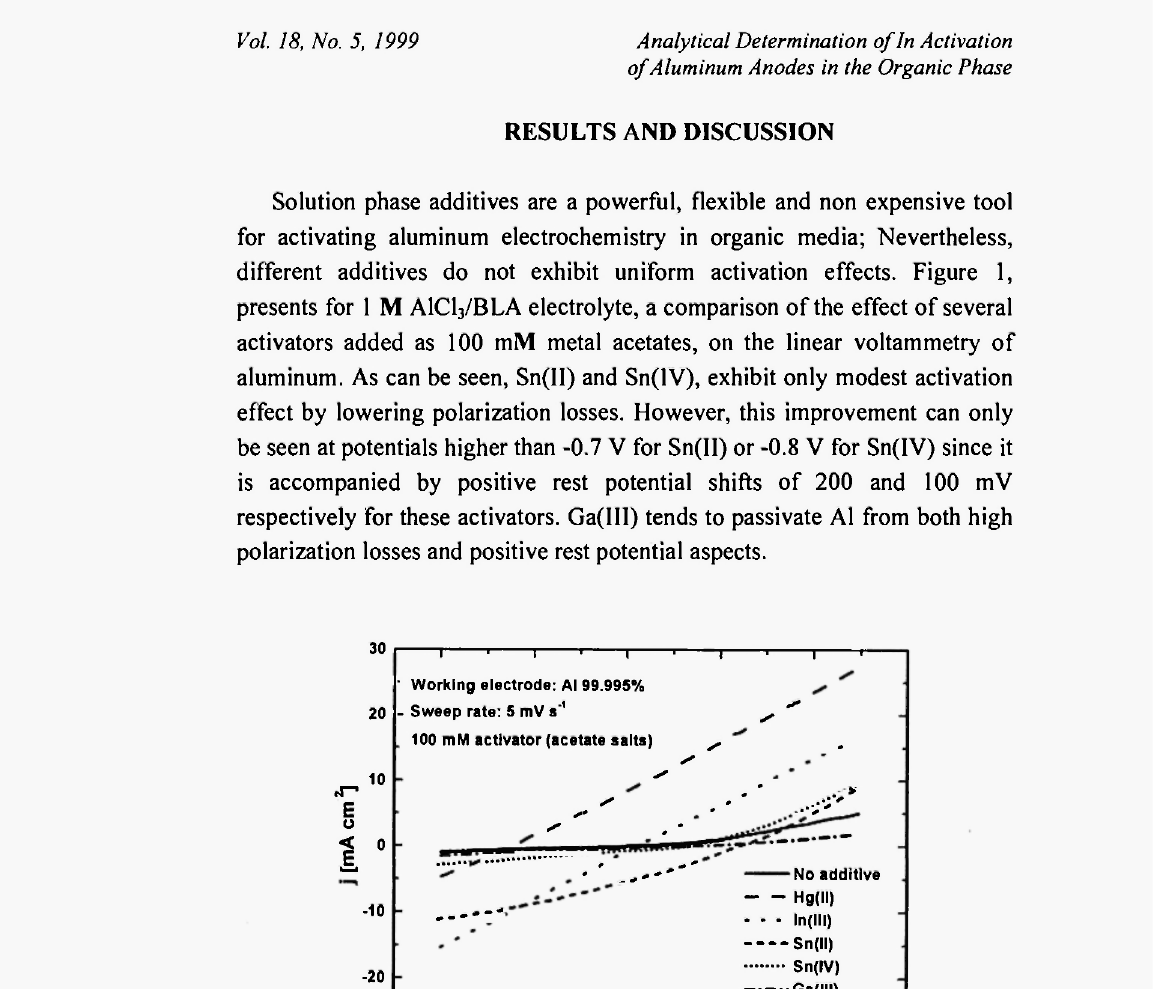
Fig. 1: The effect of Hg(ll), In(IlI), Sn(Il), Sn(lV) or Ga(lII) 100 mM activators added to a 1 Μ A1C1 3 /BLA electrolyte, on the I-V behavior of Al